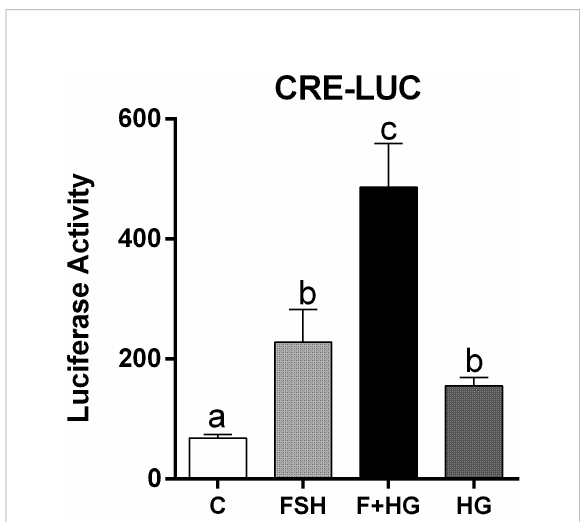
FIGURE 6 Effect of FSH on cAMP response element activation. Rat GCs were infected 2 h after plating with lentivirus carrying an empty plasmid or the pCRE-LUC reporter. 24 h later, cells were treated with FSH (50 ng/ml) in the presence or absence of HG (0.5 µM). Luciferase activity was quanti fi ed 48 h after adding FSH and HG. One-way ANOVA followed by Tukey. Columns labeled with different letters differ signi fi cantly a-b and b-c, p < 0.05; a-c p < 0.01, n = 3.